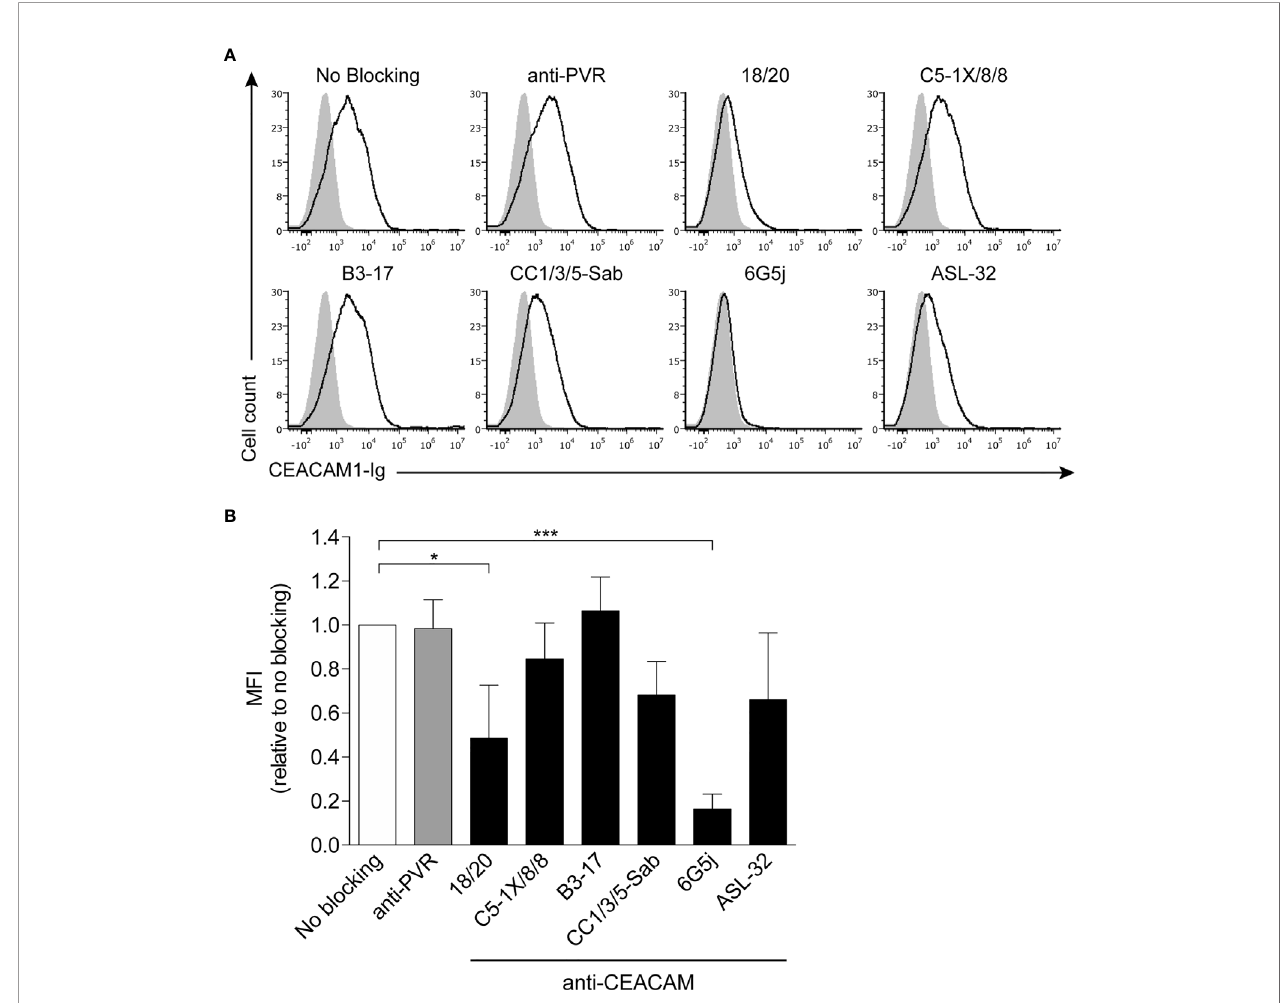
FIGURE 3 | Binding of CEACAM1 to Fnn is blocked by anti-CEACAM1 18/20 and 6G5J. (A) FITC-labeled Fnn were stained with 2 m g of human CEACAM1-Ig preincubated with 1 µg of anti-PVR or different anti-CEACAM1 antibodies. 721.221 cells were used as carrier cells. Filled grey histograms represent staining with secondary antibody only. (B) Quanti fi cation of three independent experiments. Bars represent means of three independent experiments ± SD. Values obtained without blocking antibody were arbitrarily set to 1 and all other values were normalized accordingly. Statistical signi fi cance was assessed using one-way ANOVA with Dunnett ’ s multiple comparison test. *p ≤ 0.05; ***p ≤